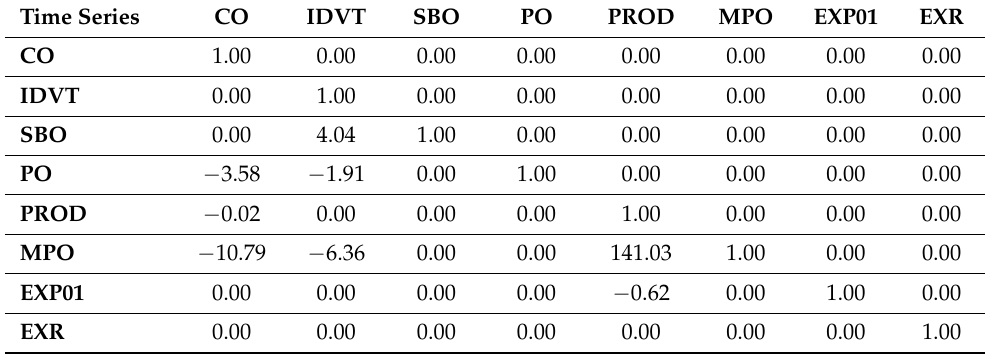
Table 6. Recovered structural matrix A under the first set of restrictions in Table 4.